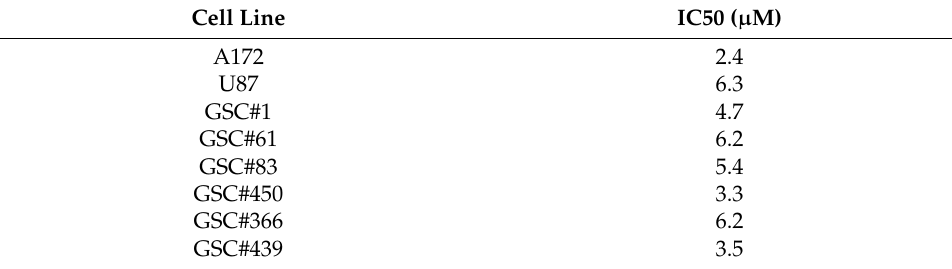
Table 3. Regorafenib IC50